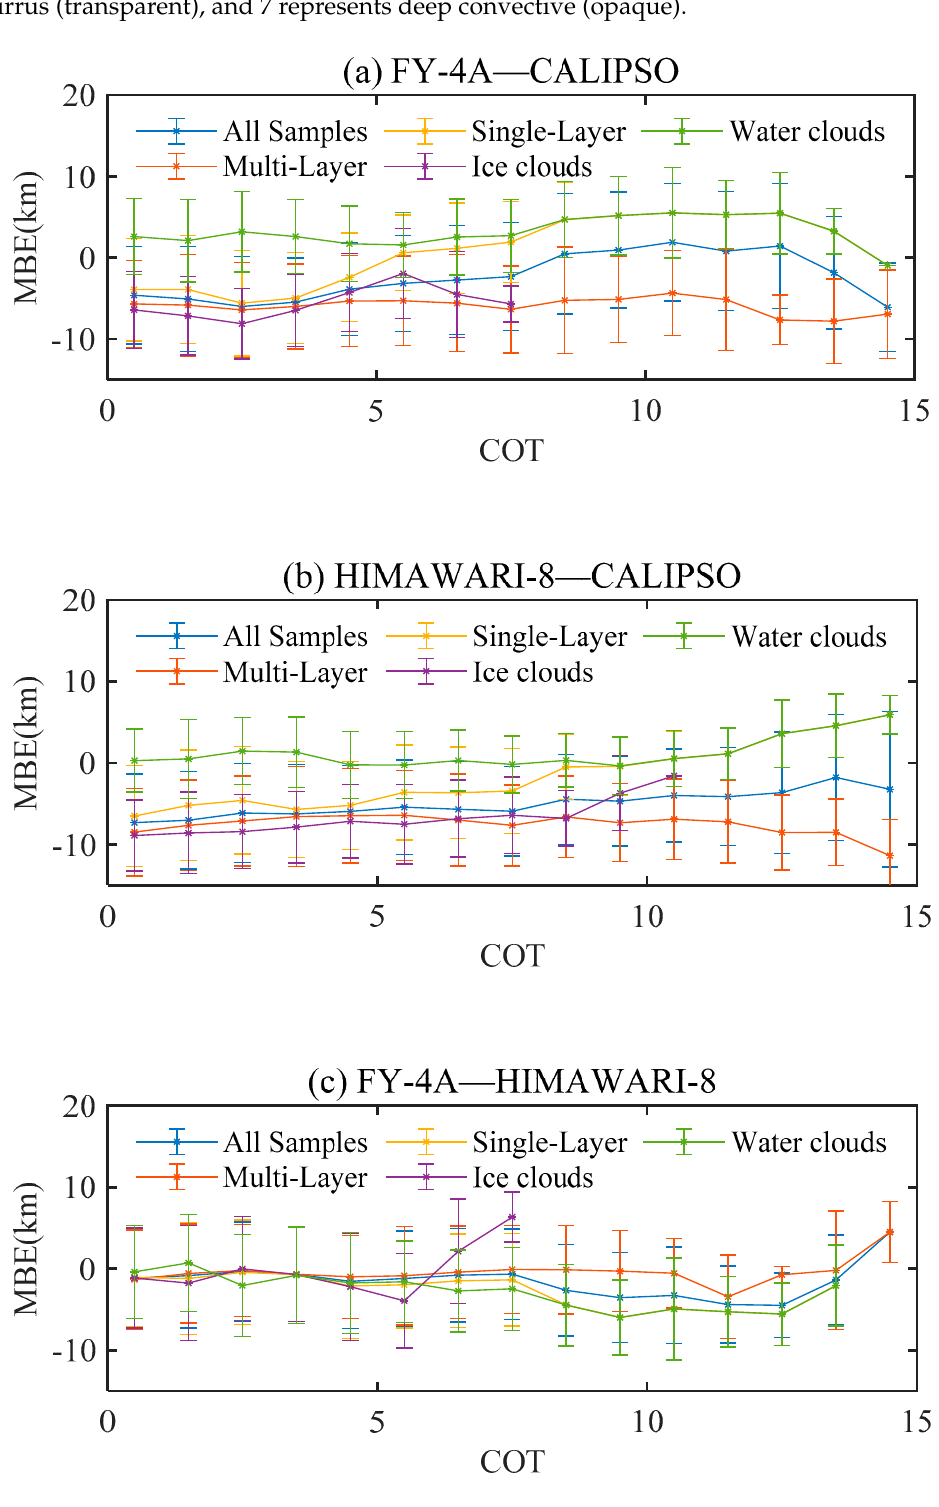
4 represents altocumulus (transparent), 5 represents altostratus (opaque), 6 represents cirrus (transparent), and 7 represents deep convective (opaque).